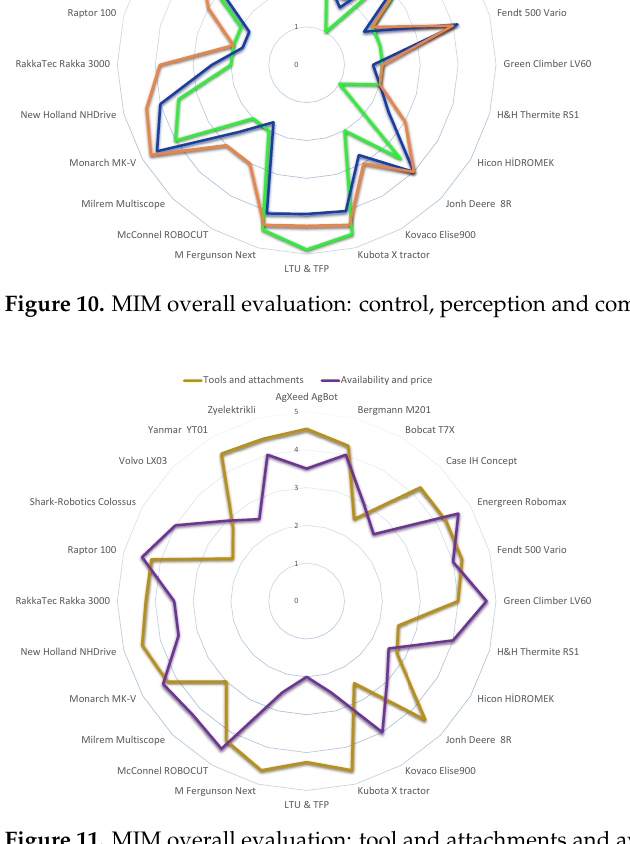
Figure 11. MIM overall evaluation: tool and attachments and availability and price KPIs.